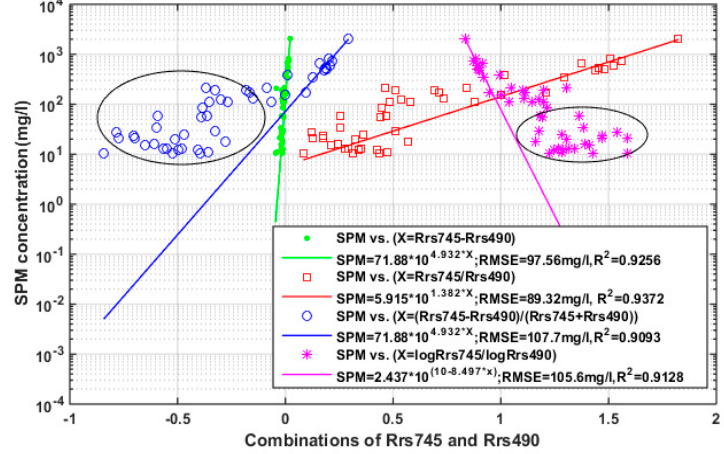
Figure 4 . Comparisons of the models constructed on the basis of SPM concentrations (mg/L) and the combinations of reflectance at 745 nm and 490 nm, in the forms of difference of the two bands, SI and band ratio, or band ratio in log scale, respectively.